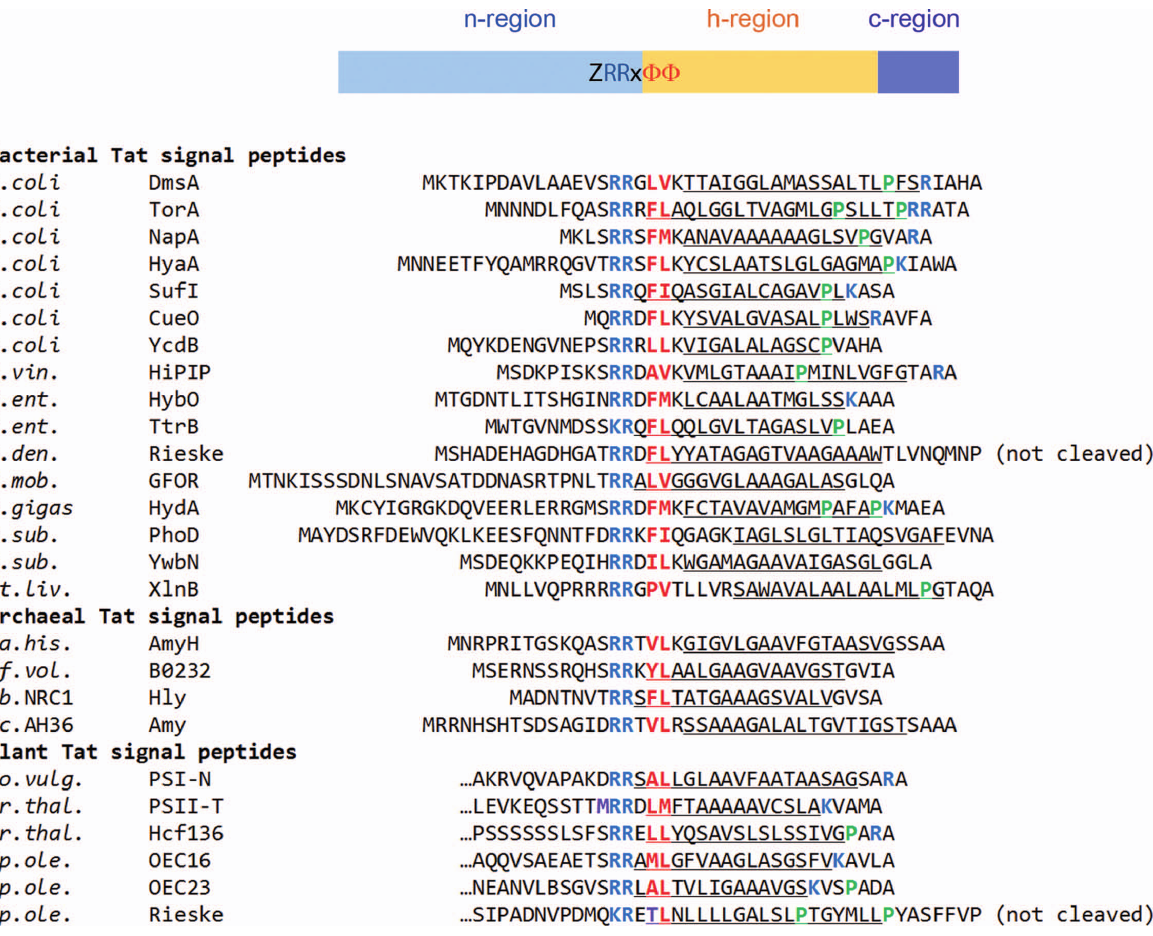
Figure 1 Tat signal